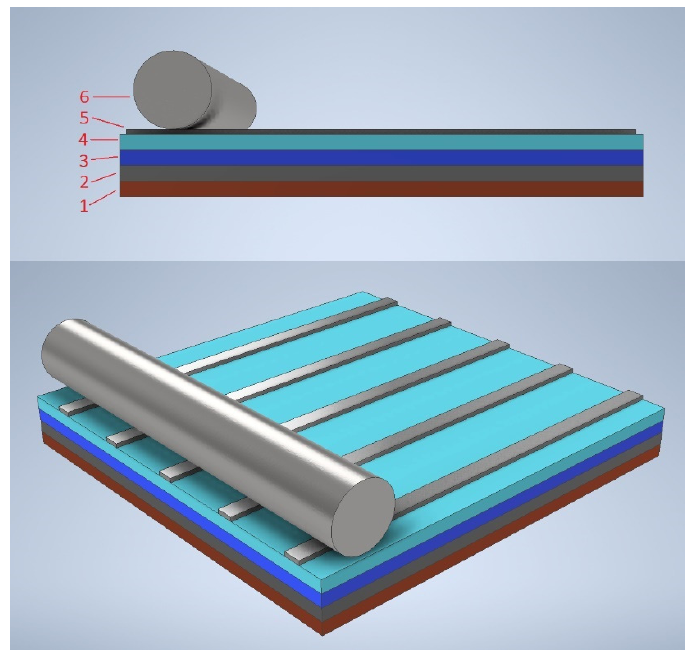
Figure 1. Schematic diagram of the new photovoltaic device: 1, Al/Cu substrate; 2, CuO/SnS layer; 3, ZnO layer; 4, AZO layer; 5, printed finger electrode; 6, smartwire. 3, ZnO layer; 4, AZO layer; 5, printed finger electrode; 6,